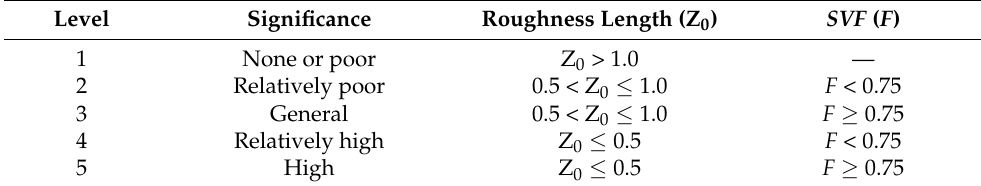
Table 3. Ventilation potential levels and their significance.